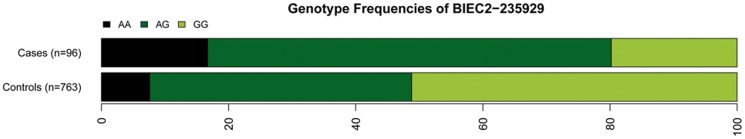
Genotype frequencies of the best associated SNP BIEC2-235929.The genotype distribution indicates a dominant or additive effect of the trait-associated variant.